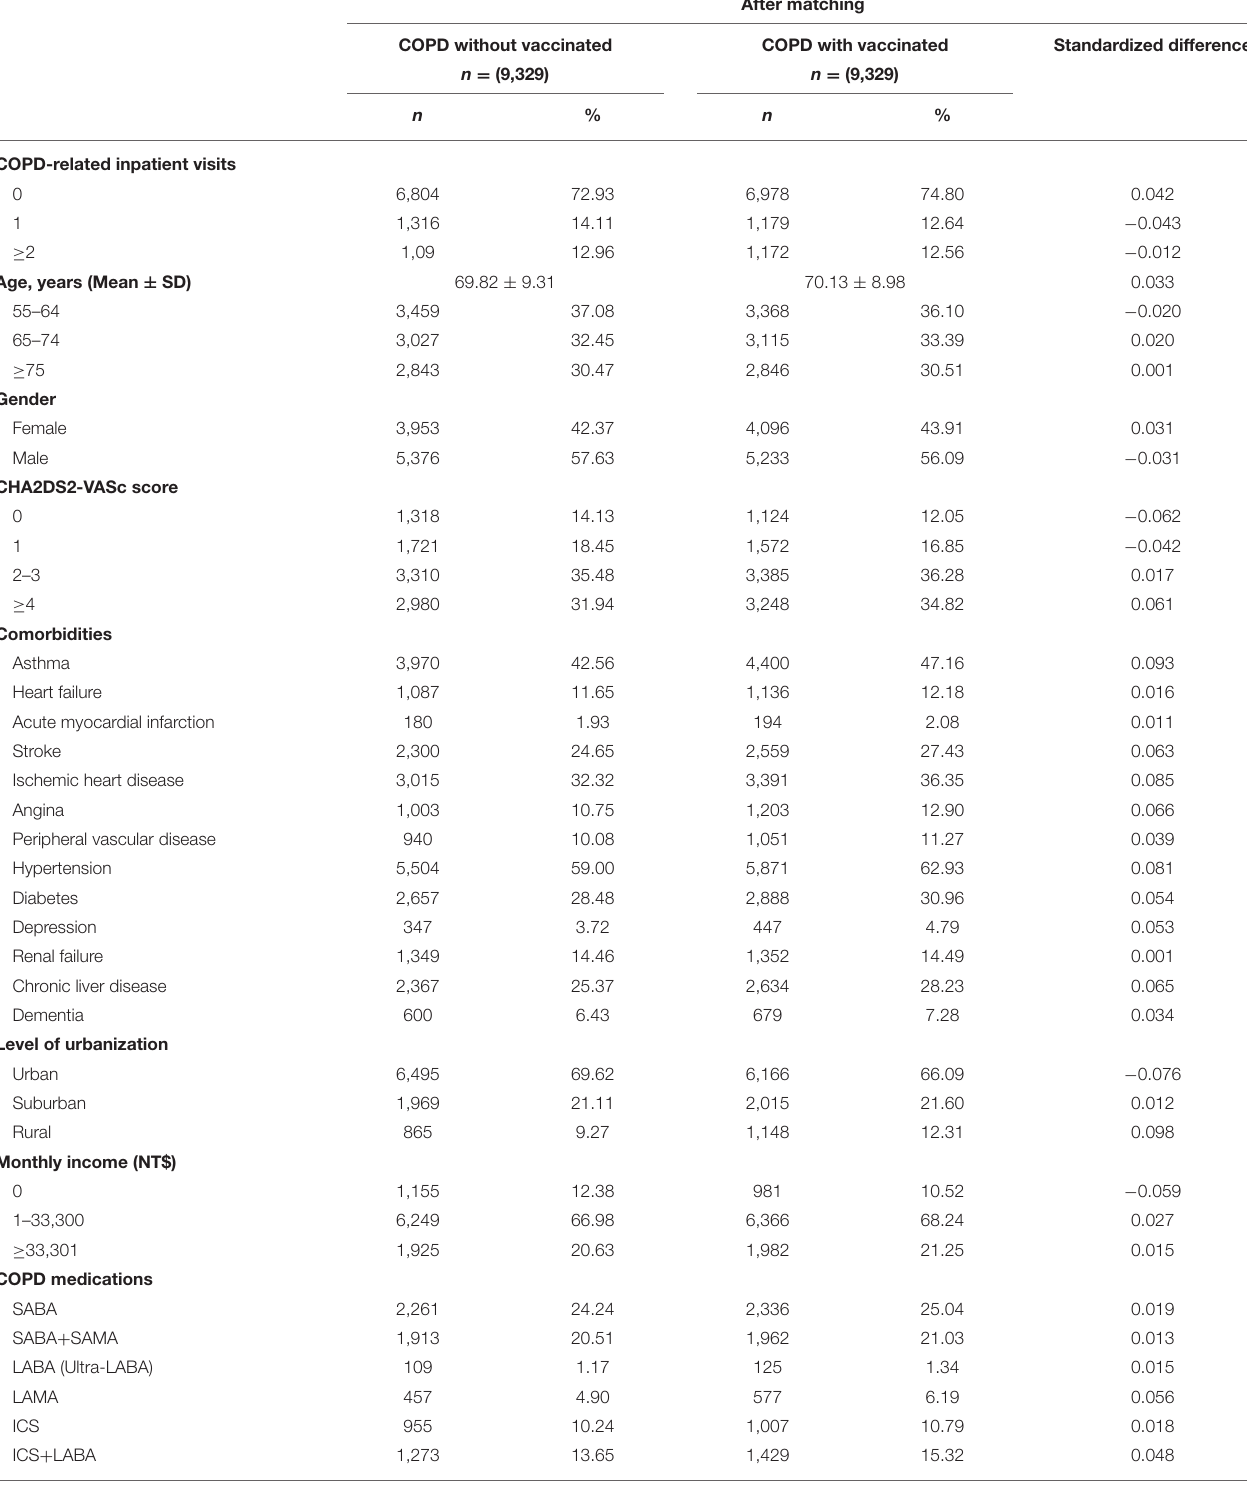
TABLE 1 | Pooled baseline characteristics balance before and after propensity score matching. After matching COPD without vaccinated COPD with vaccinated Standardized